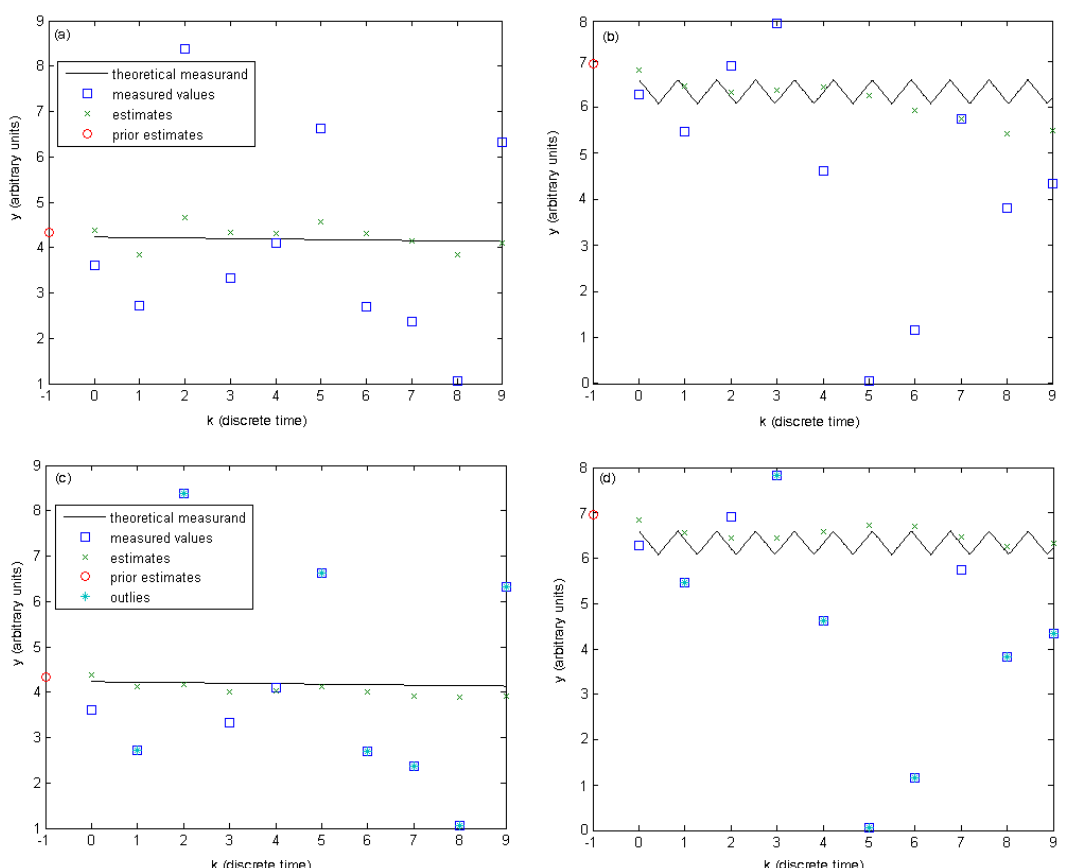
Fig. 5. Comparison between KF routine with fuzzy outlier treatment off (a, b) or on (c,